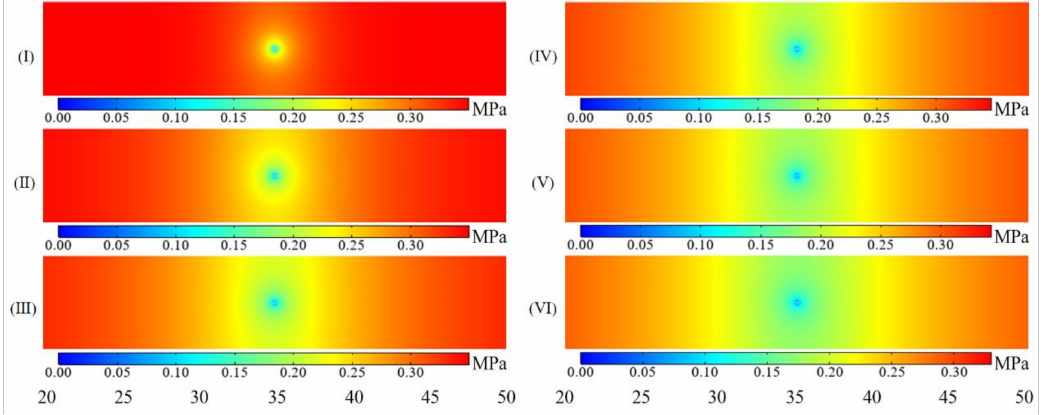
Figure 14. Cloud chart of gas pressure distribution around borehole at different drainage